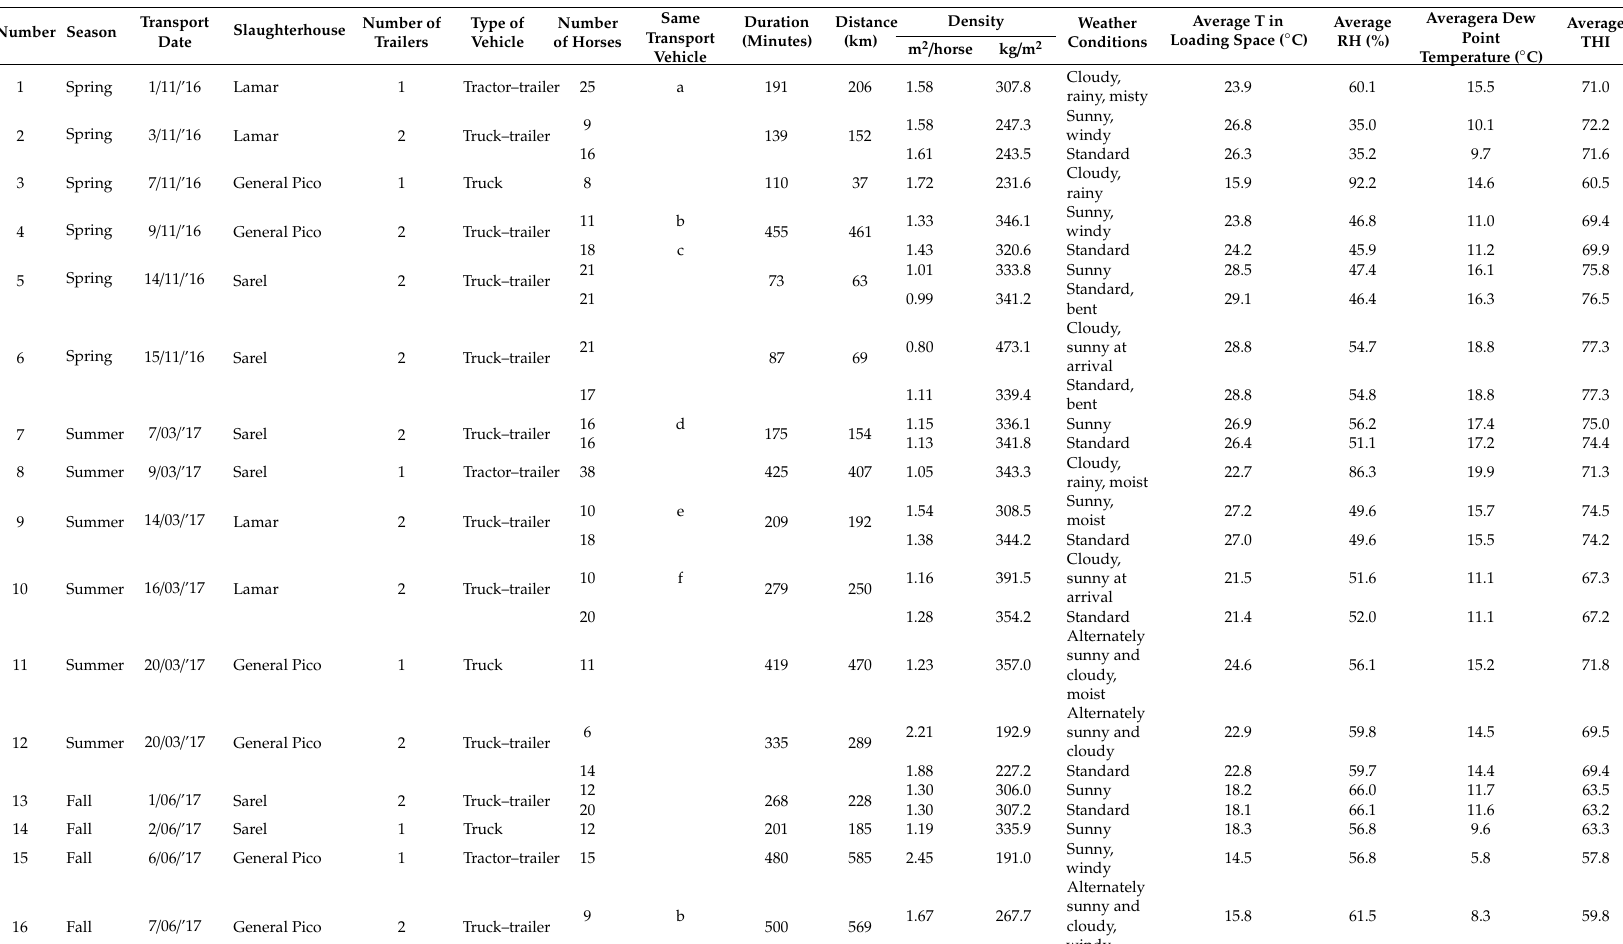
Table A4. Some details of the transport conditions. If in the column “weather conditions” “rain” is mentioned, this does not necessarily mean that it rained continuously during loading, transport and / or